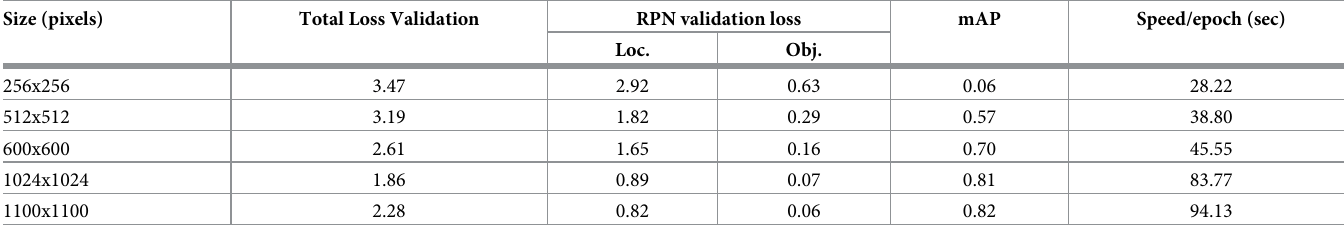
Table 5. Comparison of detection results when changing image size from 256 pixels to 1100 pixels. Size (pixels) Total Loss Validation RPN validation